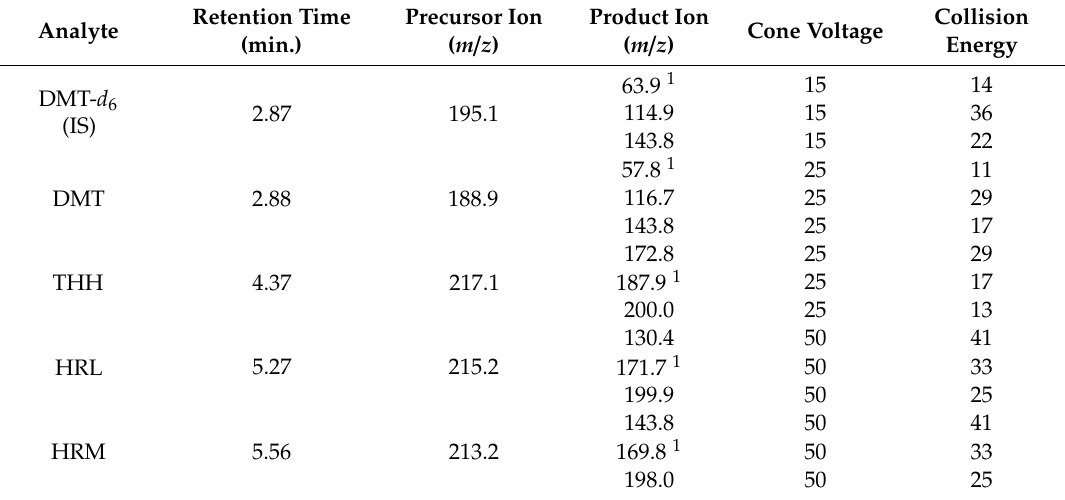
Table 2. Precursor ions, product ions, retention times, cone voltage, and collision energy for all analytes. Retention Time Analyte